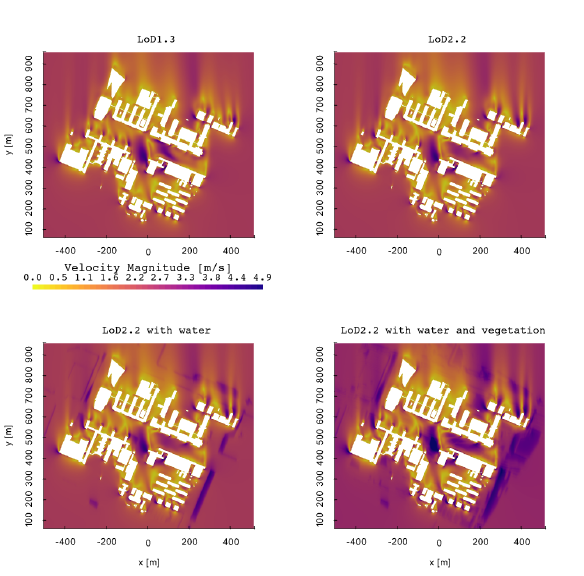
Figure 4. Velocity magnitude for the four cases at pedestrian height (1.75